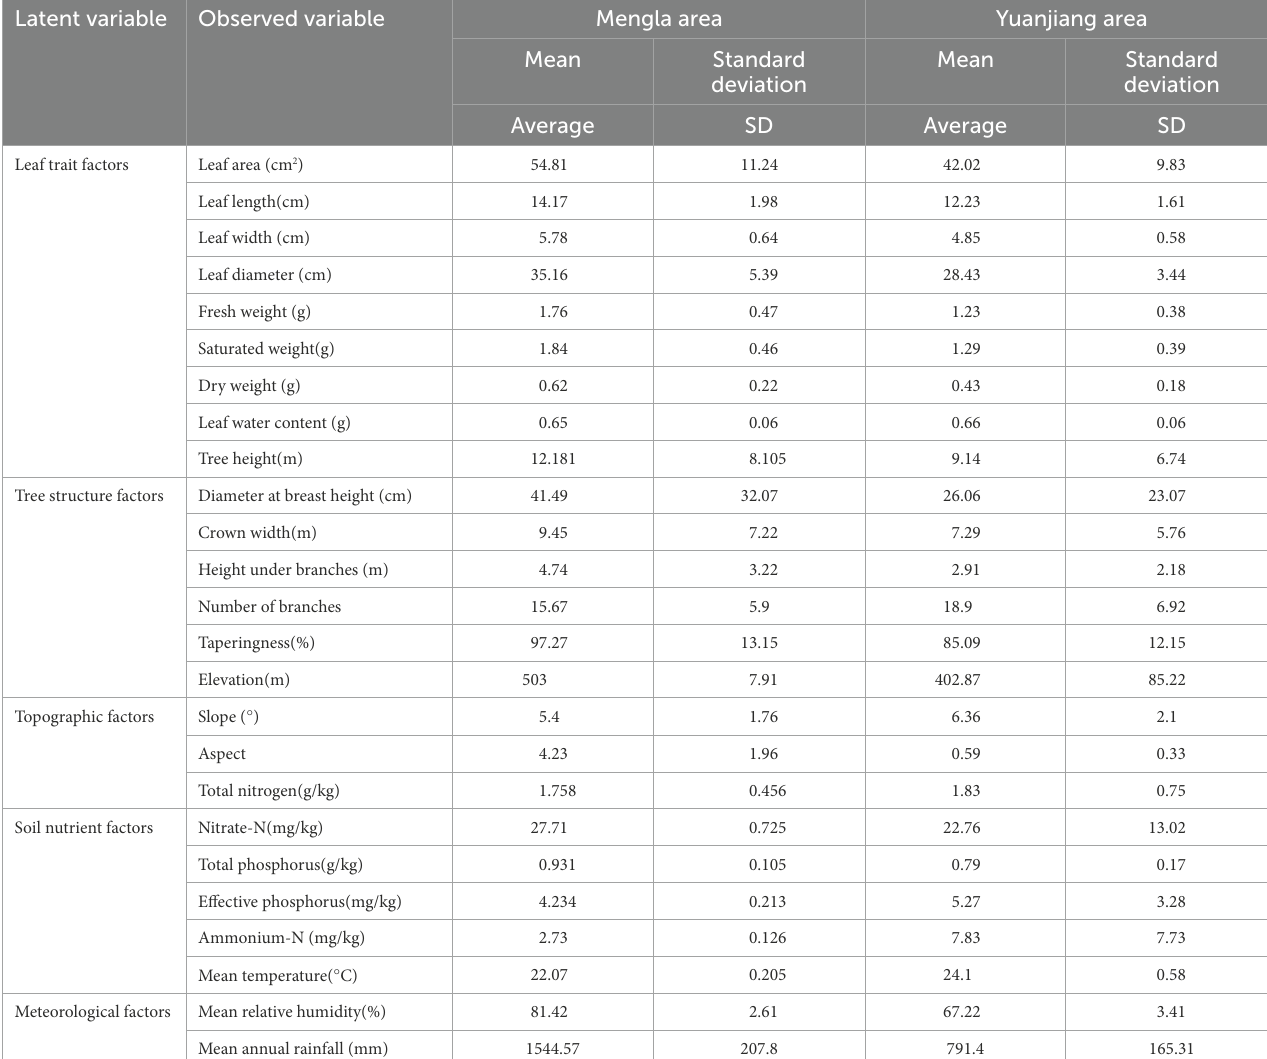
TABLE 1 Observed variables of Bombax ceiba in the two sampling areas. Latent